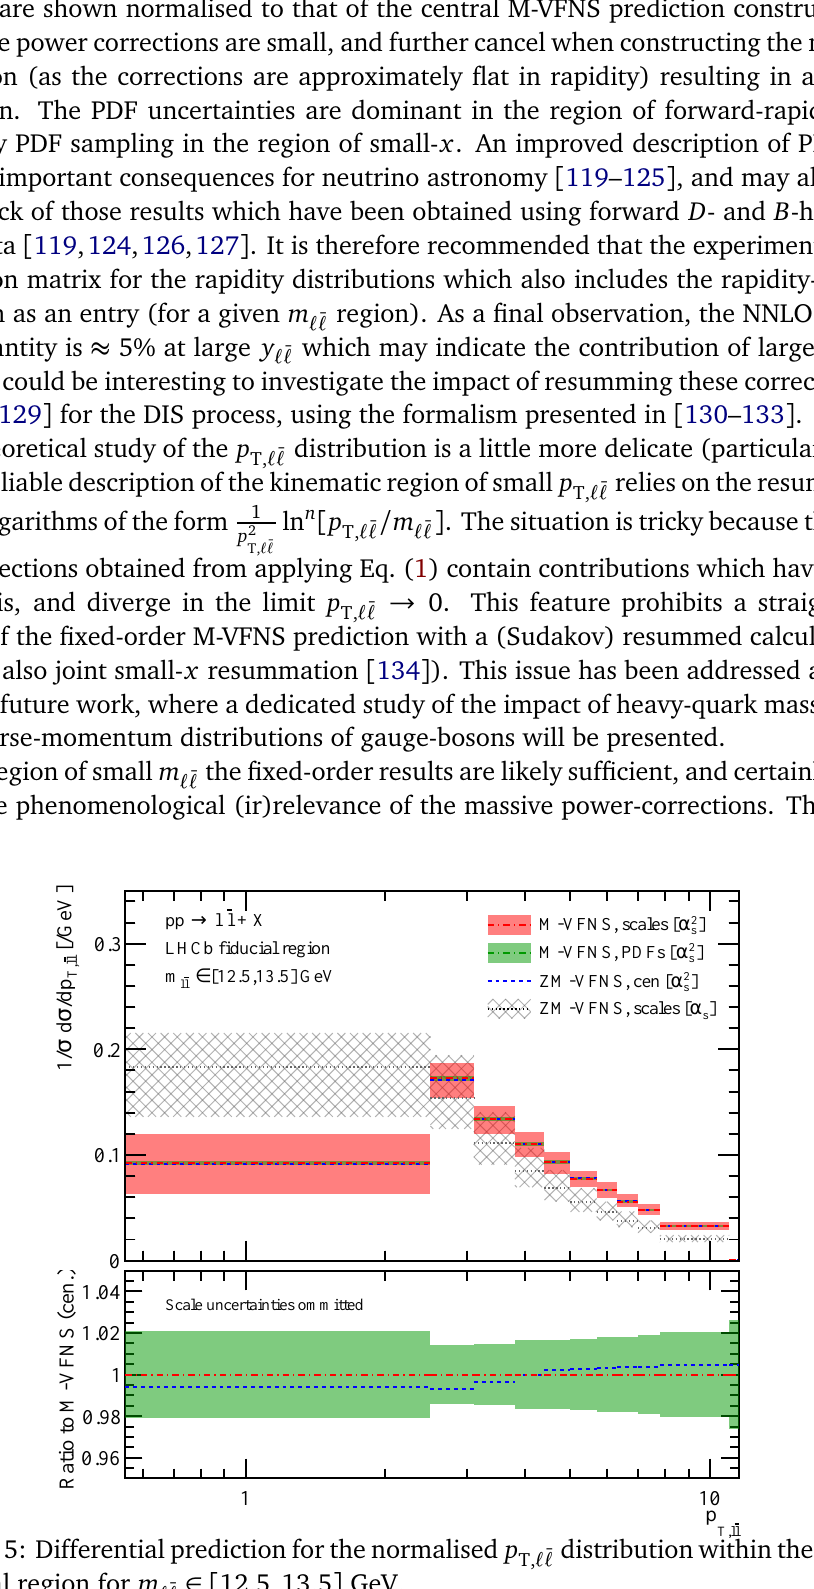
distribution within the LHCb T, (cid:96) ¯ (cid:96)